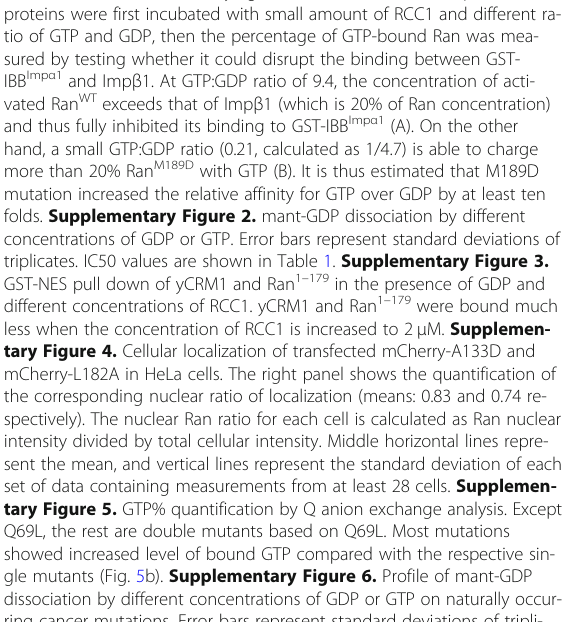
cates. Supplementary Figure 7. Cancer mutations P184S and H30Y might inhibit RanBP1 binding. Shown is the Ran-RanBP1 complex in pdb 1K5G. RanBP1 is shown as an electron static surface potential map. Ran is shown as cartoon representation. P184 and H30 are shown as sticks. Sup- plementary Figure 8. Cellular localization of cancer mutants in trans- fected HeLa cells. Ran was fused with an N-terminal mCherry fusion. The